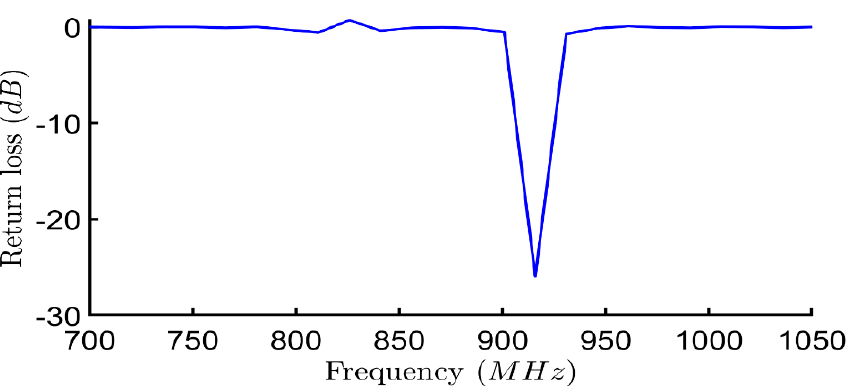
Figure 15. Return loss when the RFID antenna is fed by an MPING M70 chip.